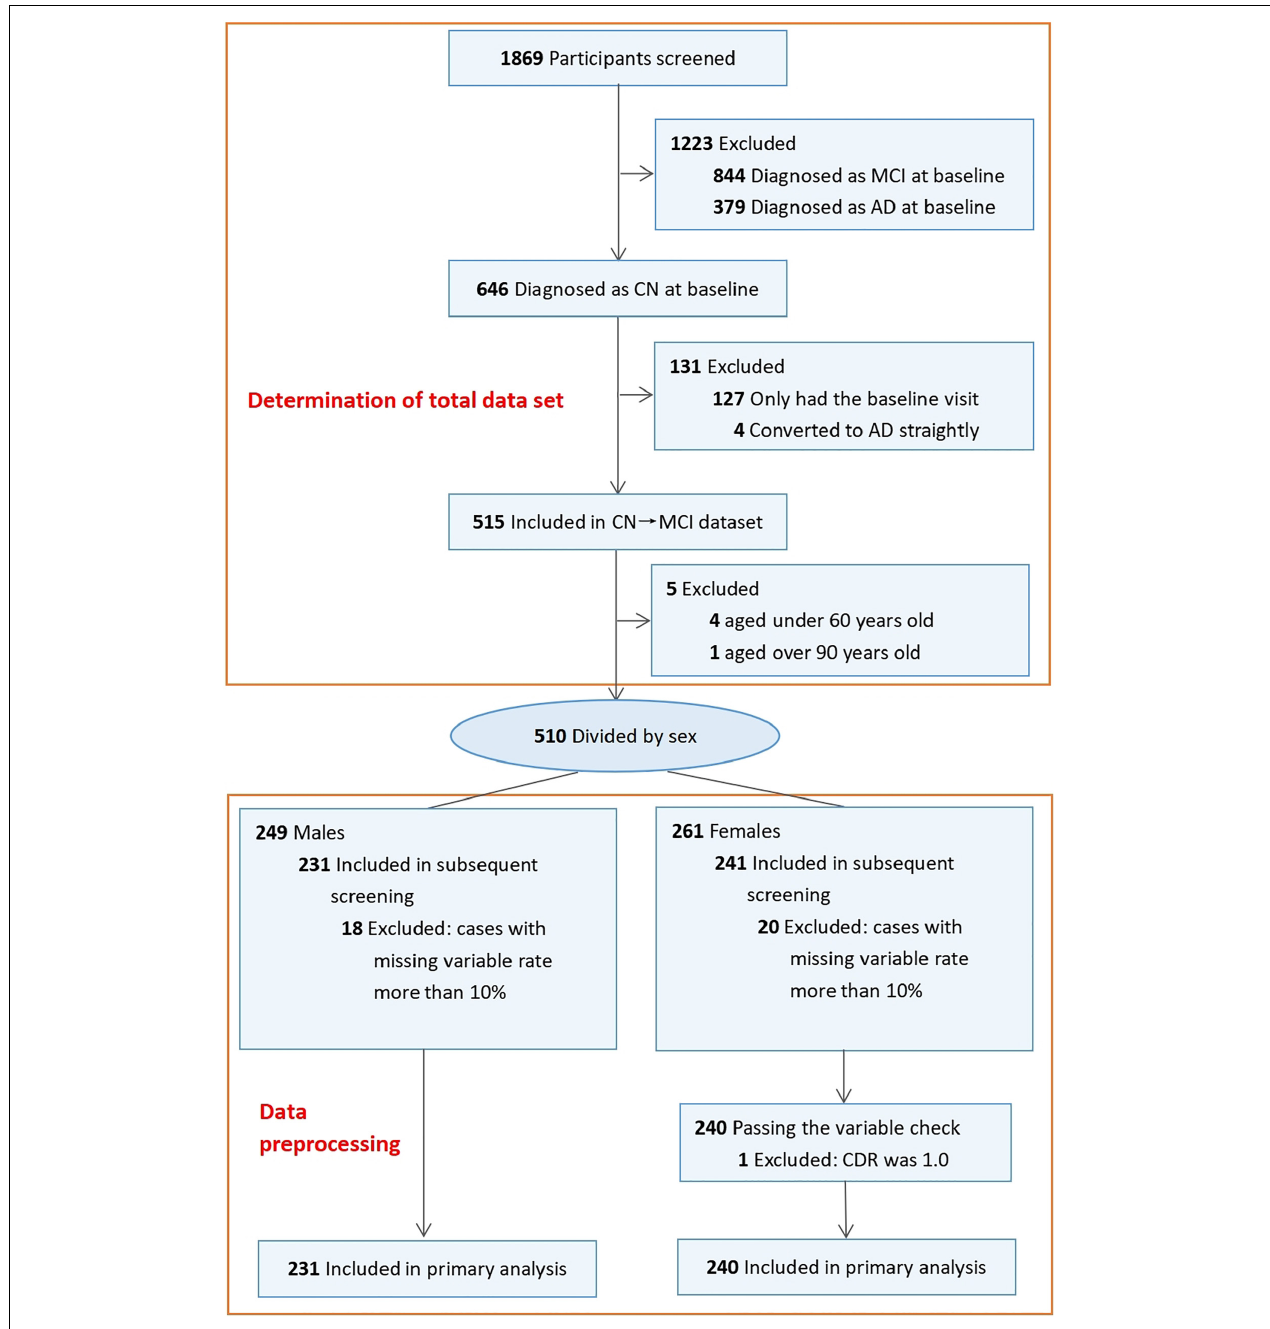
FIGURE 1 | Workflow of selected participants in